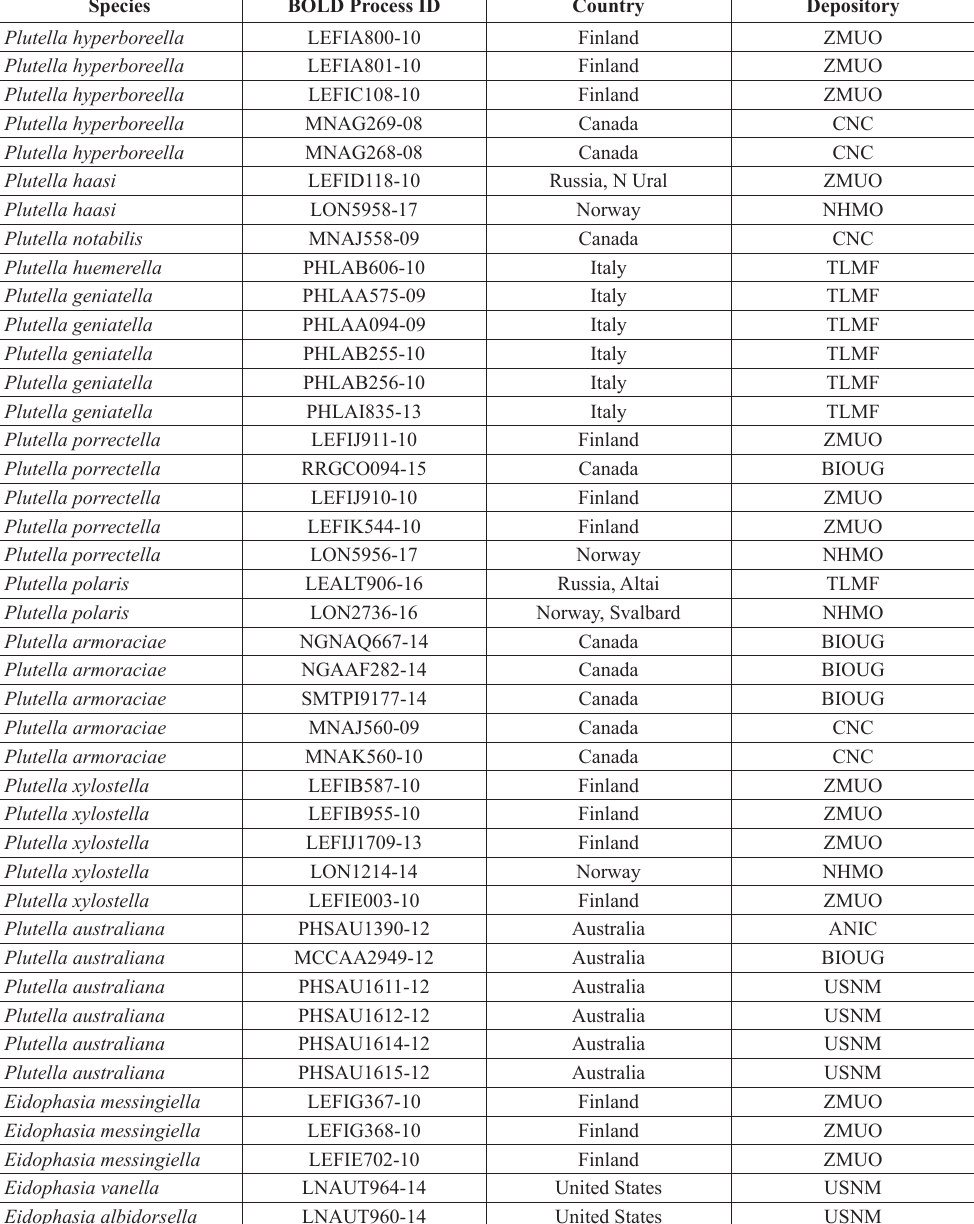
Table 2. List of specimens included in the DNA barcode analysis together comprising 52 nucleotide